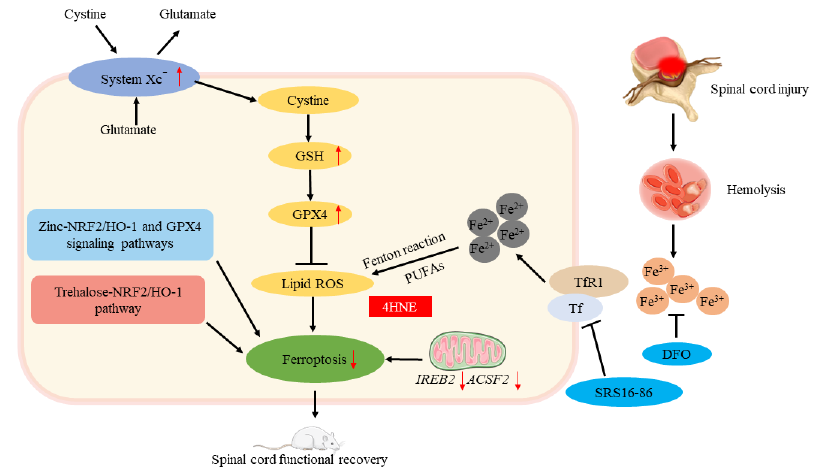
Figure 5. Ferroptosis and spinal cord injury. The roles of ferroptosis in spinal cord injury. ↑ increase, ↓ decrease.